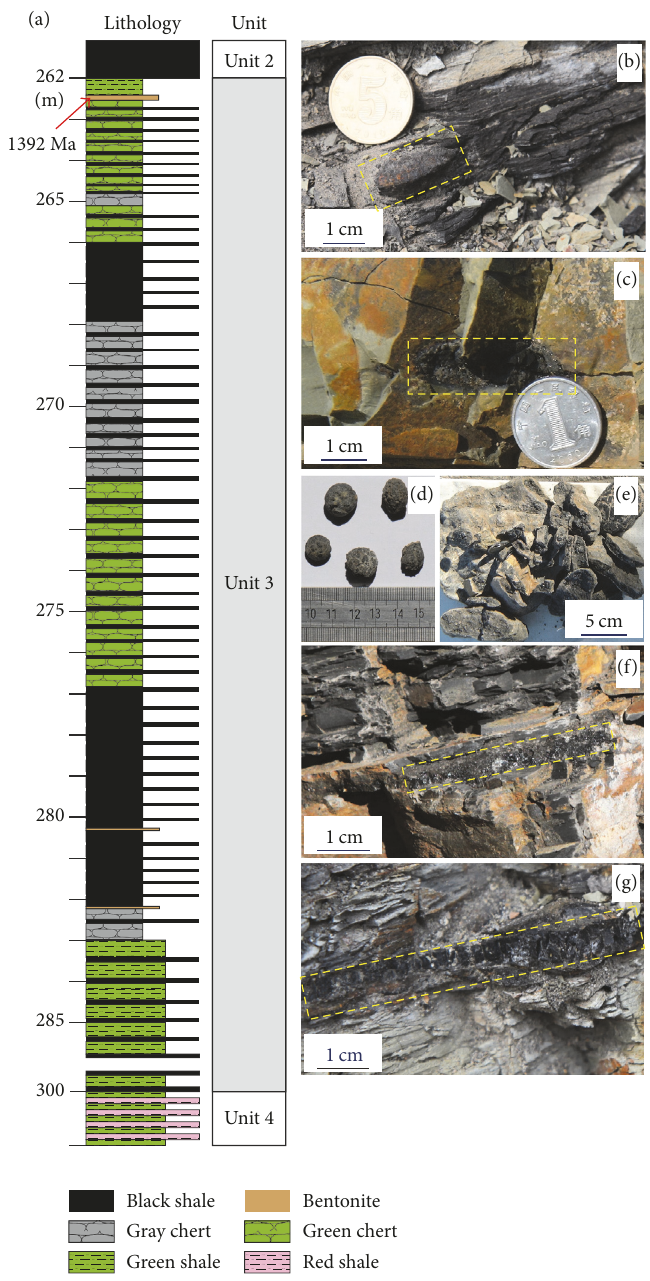
Figure 1: Generalized stratigraphy of unit 3 of Xiamaling Formation (a), representative photographs of the bitumen concretions embedded in black shales (b) and green cherts (c), the ellipsoidal or pie-like concretions (d-e), and the bitumen layers sandwiched between the black shales (f) and green shales